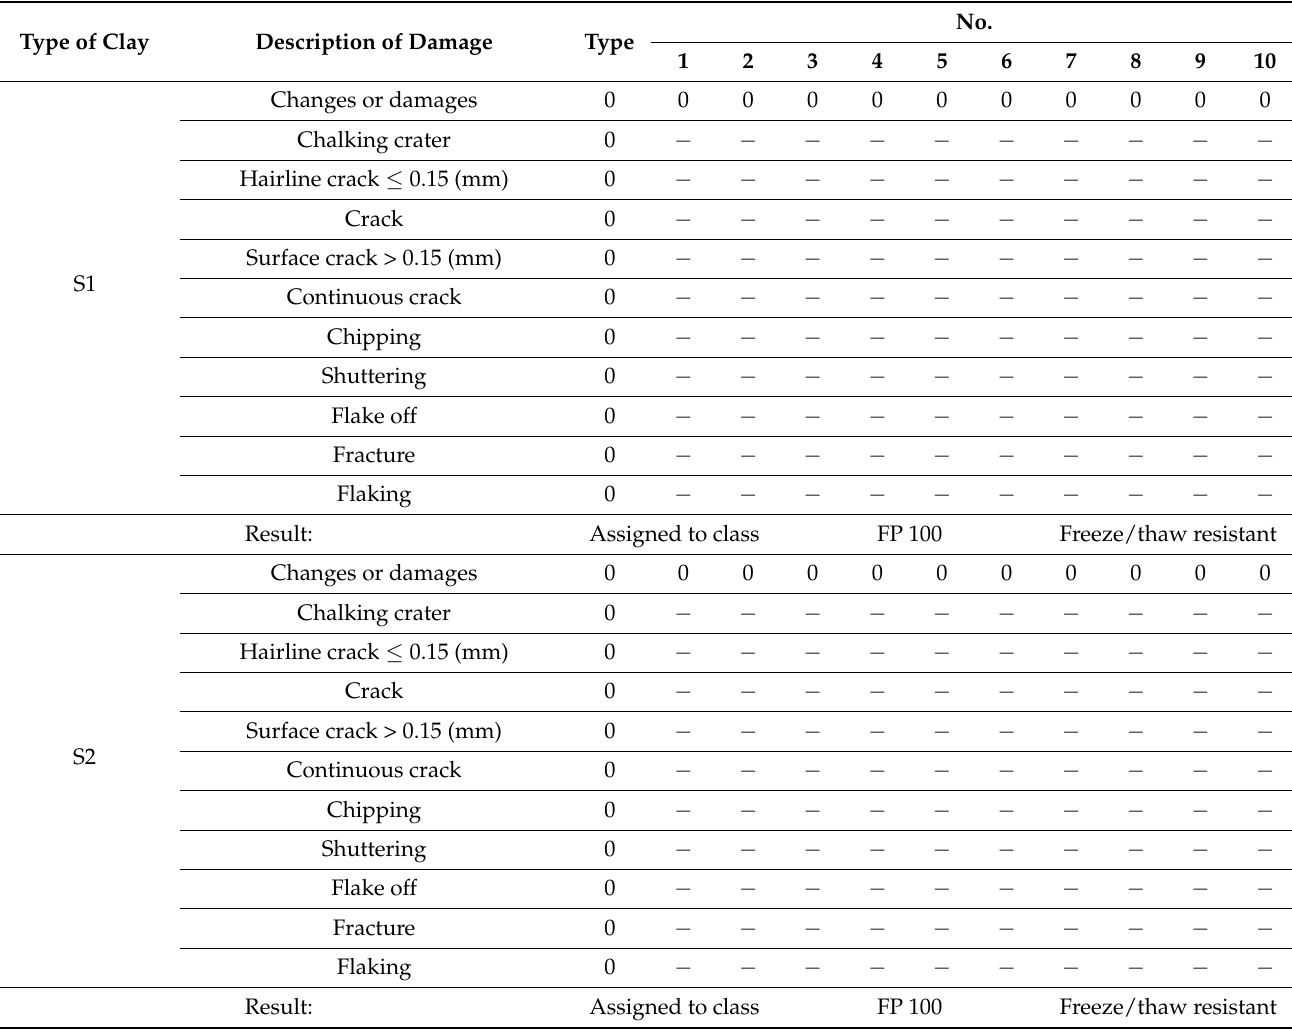
Table 5. Determination of freeze/thaw